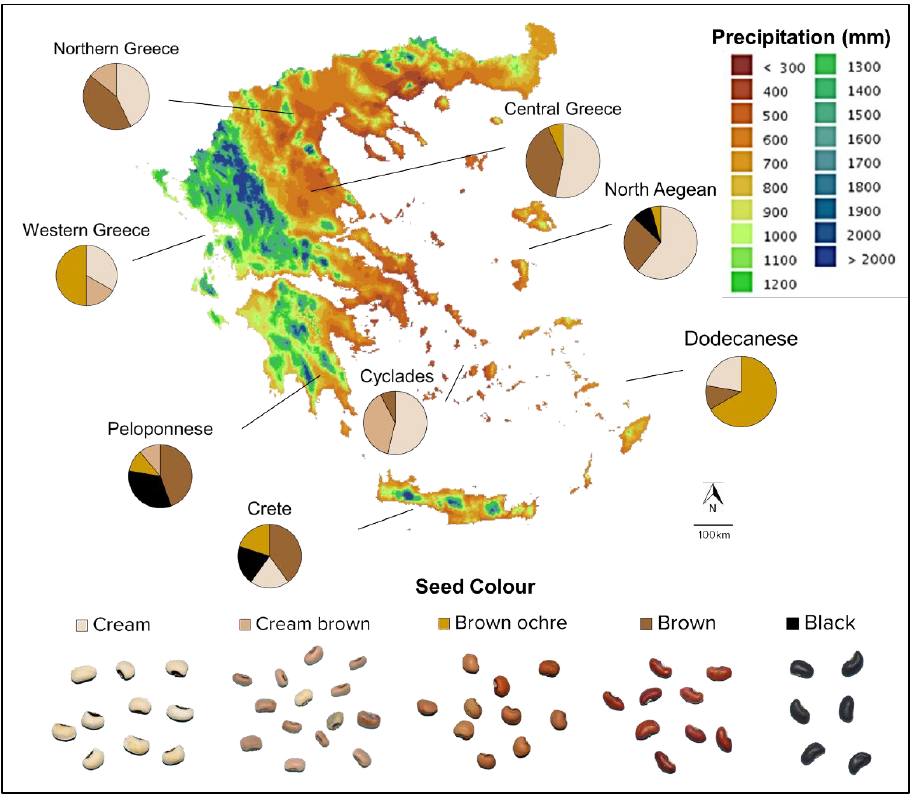
Figure 5. Map of Greece showing average annual precipitation (mm) and the composition of the different cowpea populations regarding their seed color (http://climatlas.hnms.gr/, accessed on 30 September 2022).